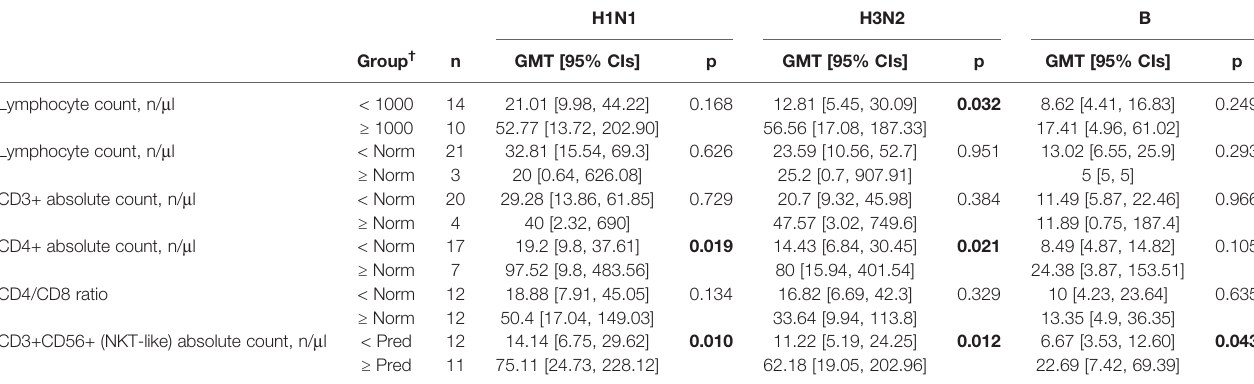
TABLE 5 | Relations between different prevaccination cellular parameters and postvaccination GMT by virus strains. Signi fi cant results are written in